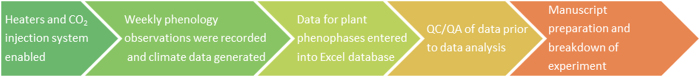
Experimental workflow diagram of PHACE phenology study.